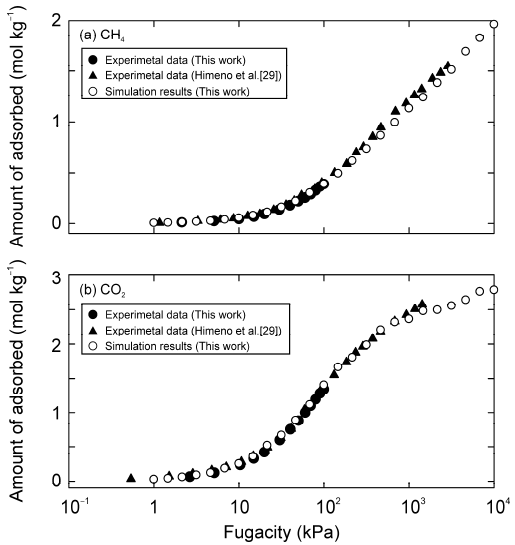
Figure 5. Adsorption isotherms of ( a ) CH 4 and ( b ) CO 2 on all-silica DDR-type zeolite at 298 K.